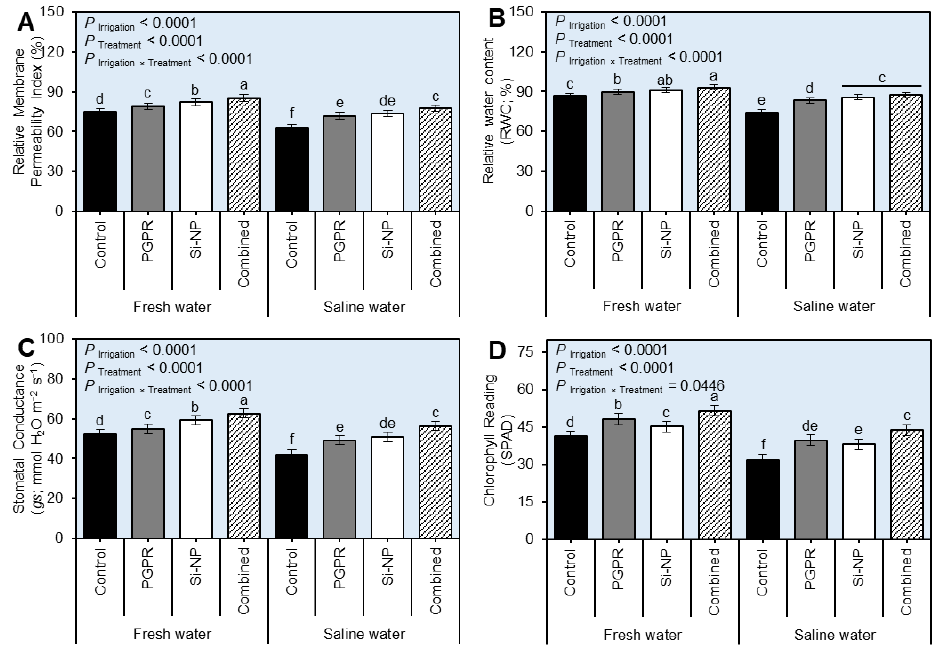
Figure 2. Effect of seed inoculation with PGPR and/or Si-NP foliar application on the water relations and chlorophyll reading of sugar beet plants grown in salt-affected soil and subjected to saline water irrigation during the 2019/2020 seasons. ( A ) Relative membrane permeability index (RMPI), ( B ) relative water content (RWC), ( C ) stomatal conductance ( gs ), and ( D ) chlorophyll reading (SPAD) during the 2019/2020 seasons, respectively. Data presented are the means ± standard deviation (mean ± SD) of three biological replicates. Different letters signify statistically significant differences between treatments according to Tukey’s HSD test ( P Irrigation × Treatment ≤ 0.05).